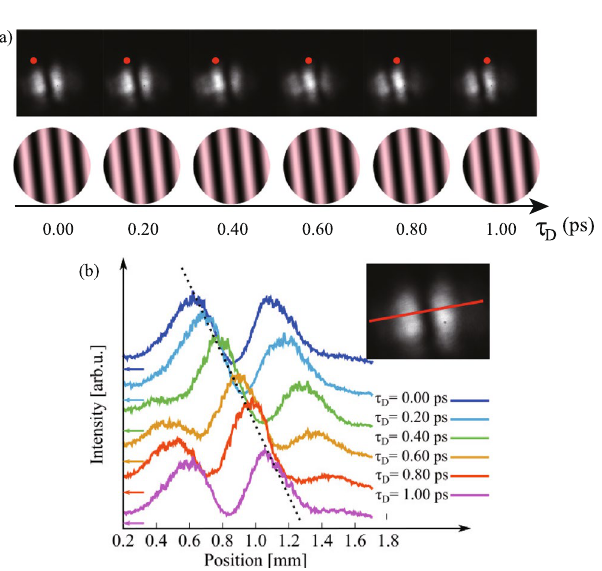
Figure 6. Ultrafast beam pattern modulation by the superposition of two chirped pulses with spatially Gaussian modes having a small crossing angle. ( a ) The time-divided spatial patterns of SFG recorded on the CMOS camera at the nominal time delay τ D between the generated pulse and the reference pulse of 0.00, 0.20, 0.40. 0.60, 0.80 and 1.00 ps. Red points in a bright line are guides for the eye. Experimental and simulated results are respectively at the top and bottom. ( b ) Intensity profiles of the modulated patterns along the red line (perpendicular to the fringes) as shown at the top right, with a parameter of the time delay τ D . Dotted line is a guide for the